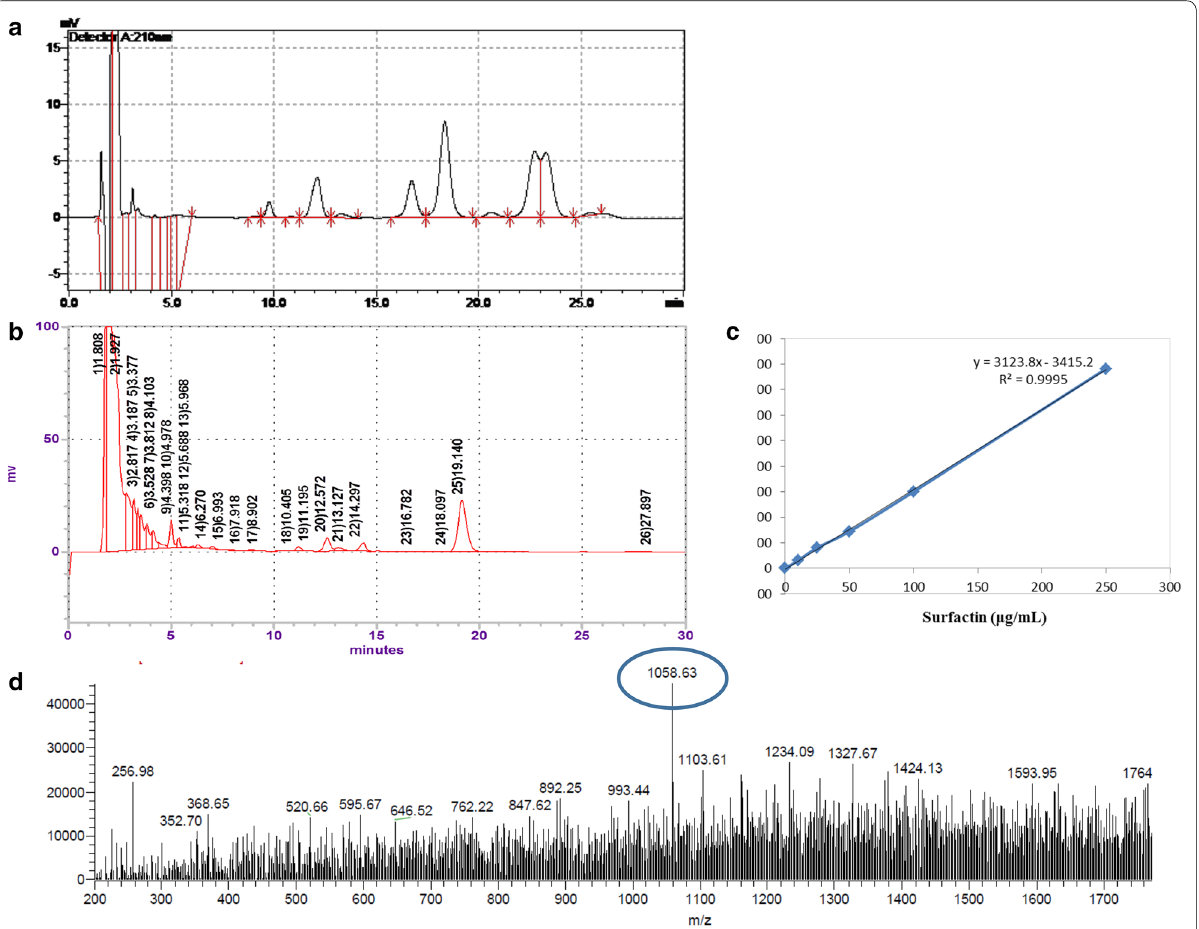
Fig. 1 Identification of the 2nd metabolites in standard substance surfactin derived from Bacillus subtilis ( a ) and fermentative sample derived from Bacillus licheniformis ‑fermented products (BLFP) ( b ) by liquid chromatography–mass spectrometry (LC–MS). Using the standard curve of surfactin derived from Bacillus subtilis ( c ), the 2nd metabolite at [M Na] + m/z 1058 in Bacillus licheniformis ‑fermented products crude extract ( d ) was + identified and